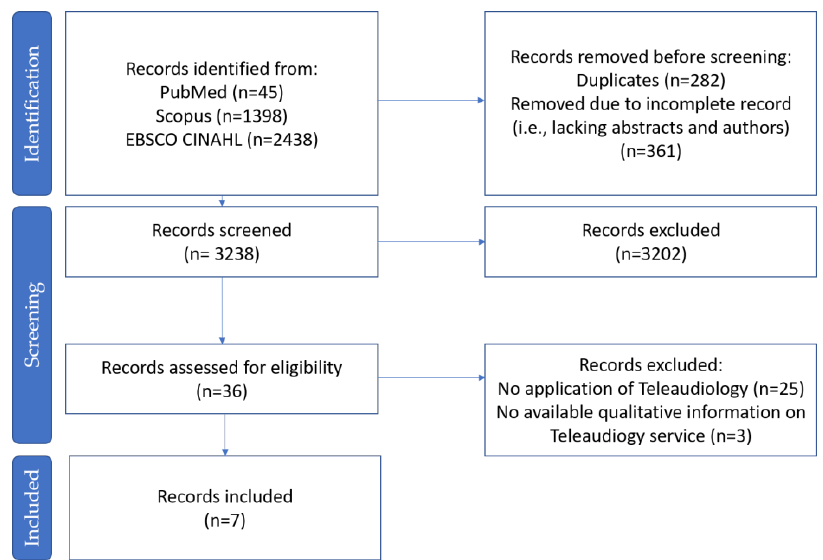
Figure 1. PRISMA 2020 flow chart (reprinted/adapted with permission from Liberati et al [30]. 2020, S. Brice).